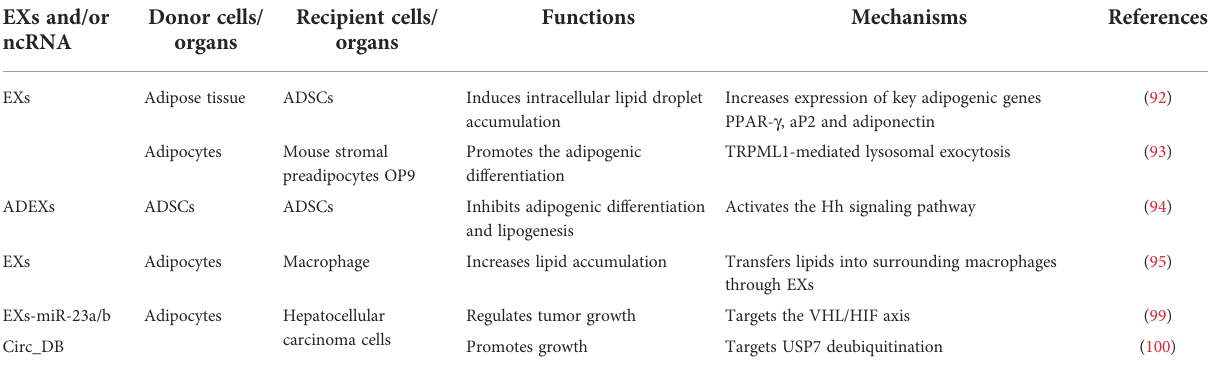
TABLE 5 ADEXs-ncRNAs and the development of obesity and various cancers. EXs